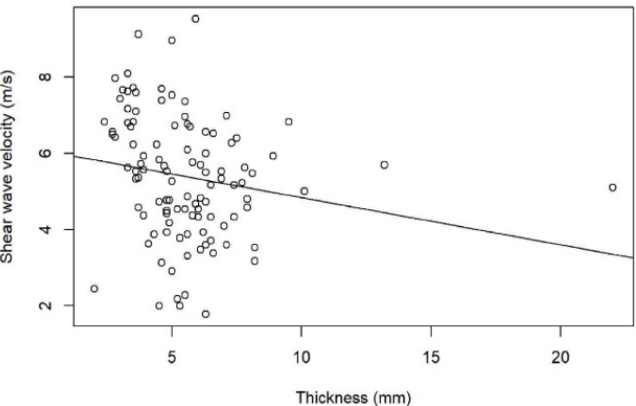
Figure 5. SWV and thickness for Patients with plantar fasciitis and Healthy volunteers, showing no correlation.